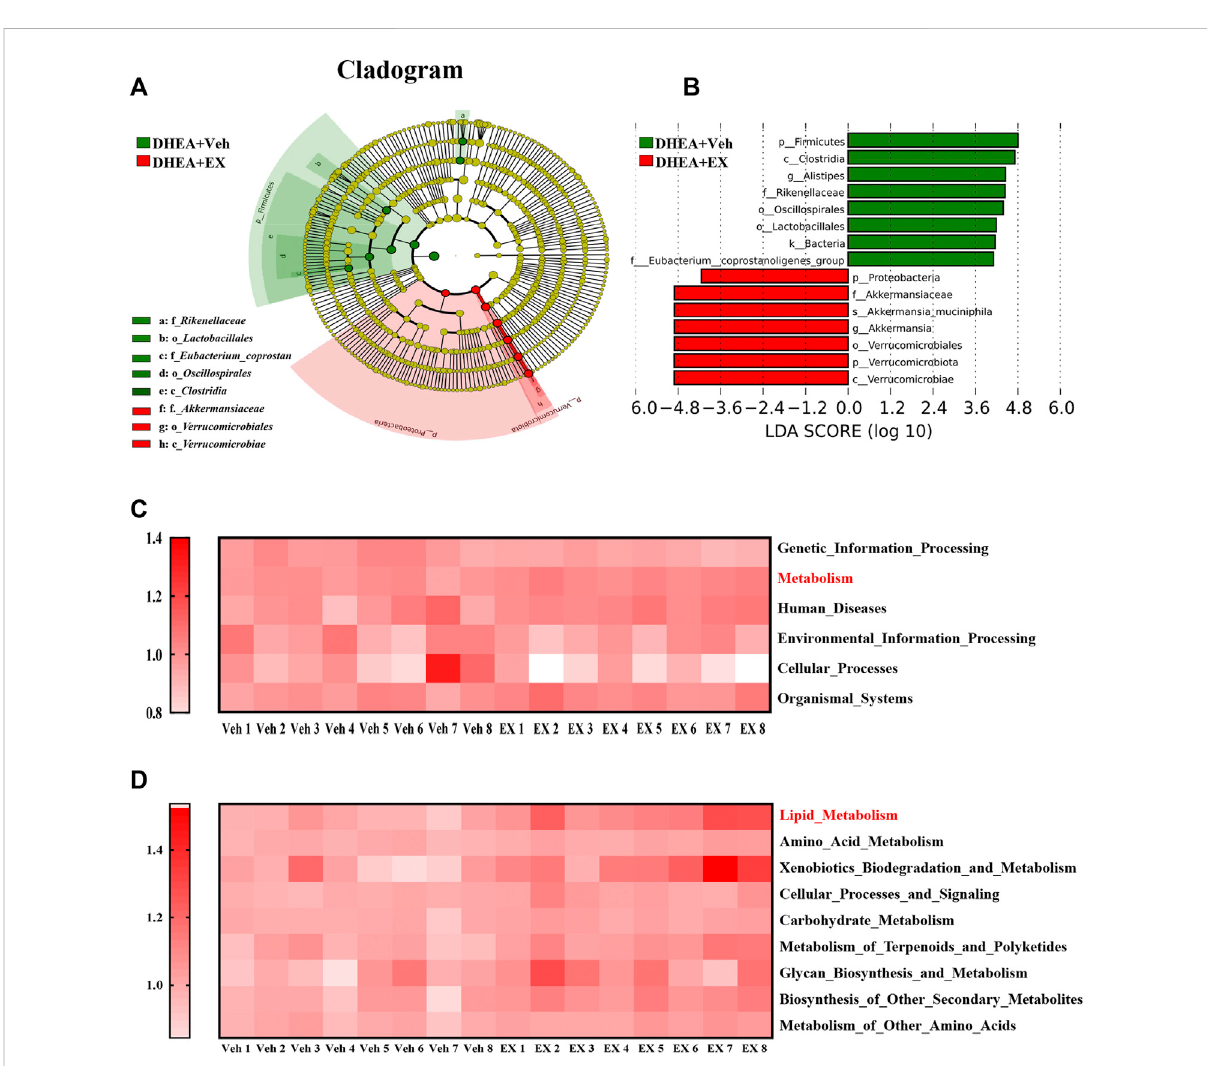
FIGURE 7 Gut microbiota comparisons between the two groups analyzed by LEfSe and KEGG. (A,B) Taxonomic cladogram generated from LEfSe of metagenomic sequencing data. Green indicates enriched taxa in the vehicle group. Red indicates enriched taxa in the enoxacin group. Each circle ’ s size is proportional to the taxon ’ s abundance. (C,D) Kyoto Encyclopedia of Genes and Genomes annotation (KEGG) of key metabolic pathways at differentlevels.Valuesarerepresentedasthemean±SE. n =5 – 6. P valuesweredeterminedbytwo-tailedStudent ’ s t- test.* p < 0.05,** p < 0.01. DHEA, dehydroepiandrosterone; Veh, vehicle; EX,